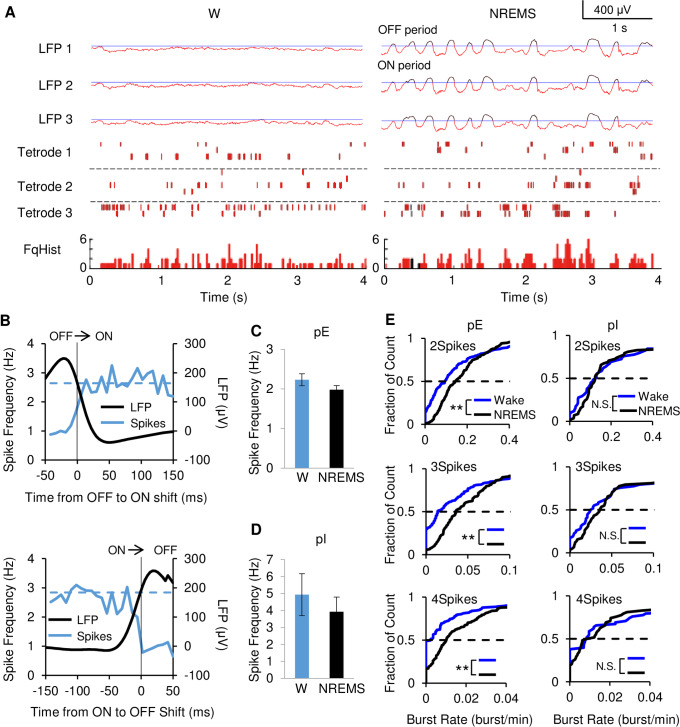
Small networks of cortical neurons change from irregular, tonic-like firing in W to rhythmic, ON/OFF burst-like activity in NREMS.(A) Simultaneous recordings from 3 tetrodes in deep layers of M1 cortex during W and NREMS. LFPs (top 3) and raster plots (middle 3) of the same 10 pE neurons during W (left) and NREMS (right). LFPs are color coded for ON periods (red) and OFF periods (black) and OFF period threshold (blue). The spikes in the raster plot are similarly color coded. Combined frequency histogram (FqHist) for all pE neurons is separately illustrated in the raster plots (Hz/25 ms) (bottom). During NREMS, the raster plots showed intermittent bursting and pauses during ON periods. In contrast, the combined frequency histogram showed sustained firing throughout the ON periods (indicating the random occurrence of individual neuronal bursting during an ON period) and no firing during OFF periods. (B) Triggered average of pE-neuron firing frequency and LFP amplitude at OFF-ON transition (top) and ON-OFF transition (bottom) for the population of pE neurons. Average firing frequency showed sustained constant increase in NREMS after transition from OFF to ON period, despite increased bursting of individual pE neurons in NREMS shown in (E). LFP (Black; right Y axis) correlated with firing frequency (Blue; Hz in 10 ms bins, left Y axis) plot during the NREMS OFF to ON transition (top) and ON to OFF transition (bottom). Average W firing frequency of the same neuron population is shown as dashed line. For OFF to ON transitions firing before transition was 0.99±0.08 Hz increasing to 2.6±0.18 Hz after transition (N = 284 transitions, p<0.01, t = -11.79, paired Student’s t-test). For ON to OFF transitions firing before transition was 2.5±0.29 Hz decreasing to 0.98±0.09 after the transition (N = 253 transitions, p<0.01, t = 6.53, paired Student's t-test). Firing during a 40 ms window at the beginning and the end of the ON period was not different (p = 0.85, t = 0.97, Student's t-test). (C) Average firing frequency throughout W and throughout NREMS for individual pE neurons. (D) Average firing frequency throughout W and throughout NREMS for individual pI neurons. (E) Cumulative histogram of the number of bursts per minute (Burst Rate) for 212 pE neurons (left) and 58 pI neurons (right). Plots for burst lengths of two (2Spikes), three (3Spikes) and four (4Spikes) spikes per burst. W (blue line) and NREMS (black line). Bursts are two or more spikes with interspike intervals<15 ms. Burst rates increased significantly from W to NREMS for pE (p < 0.01, Wilcoxon related samples signed rank test), but not for pI (p = 0.837 in 2Spikes, p = 0.118 in 3Spikes, p = 0.985 in 4Spikes, Wilcoxon related samples signed rank test). Double asterisks indicate p-value below 0.01 (Wilcoxon related samples signed rank test).